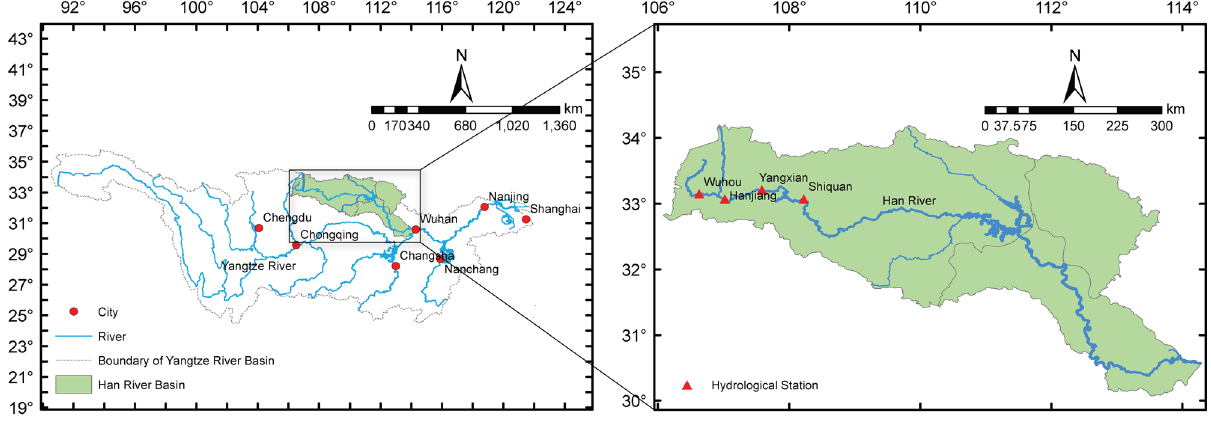
Figure 3. Location of the Yangxian hydrological station.